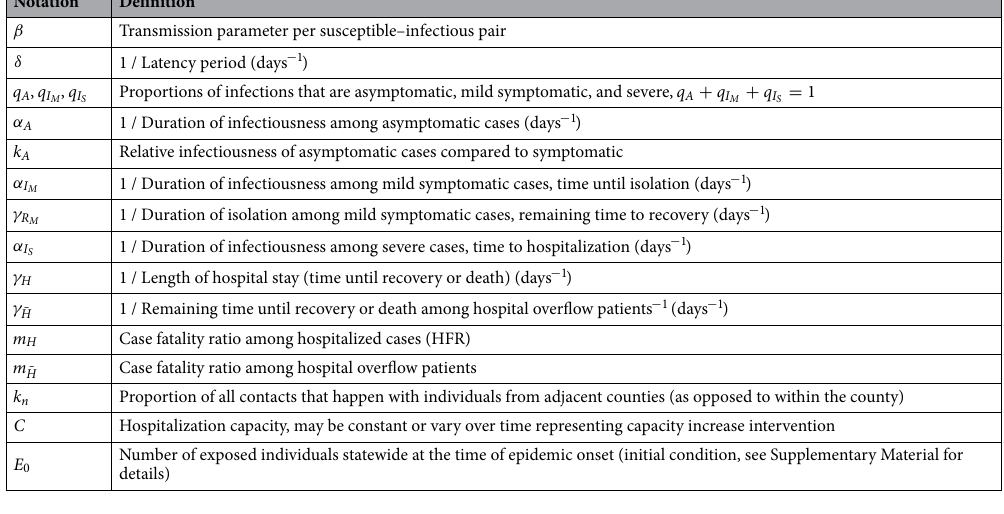
Table 1. Transmission model